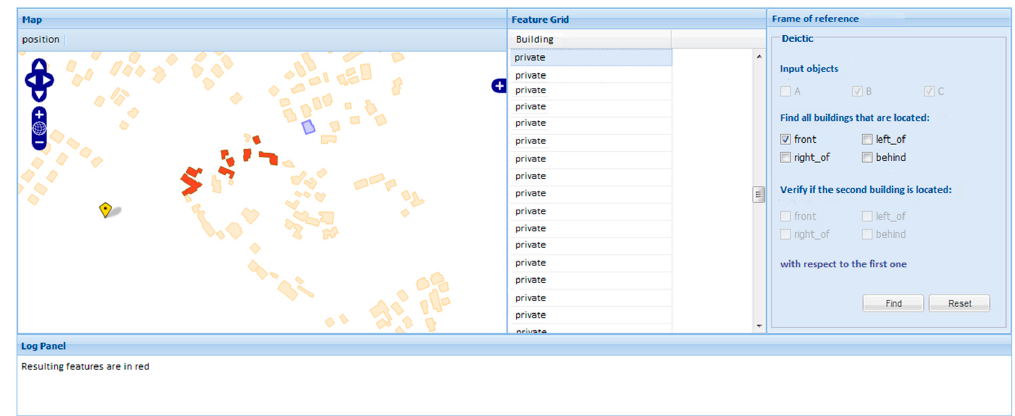
Figure 17. Setting user’s position in the deictic frame of reference.